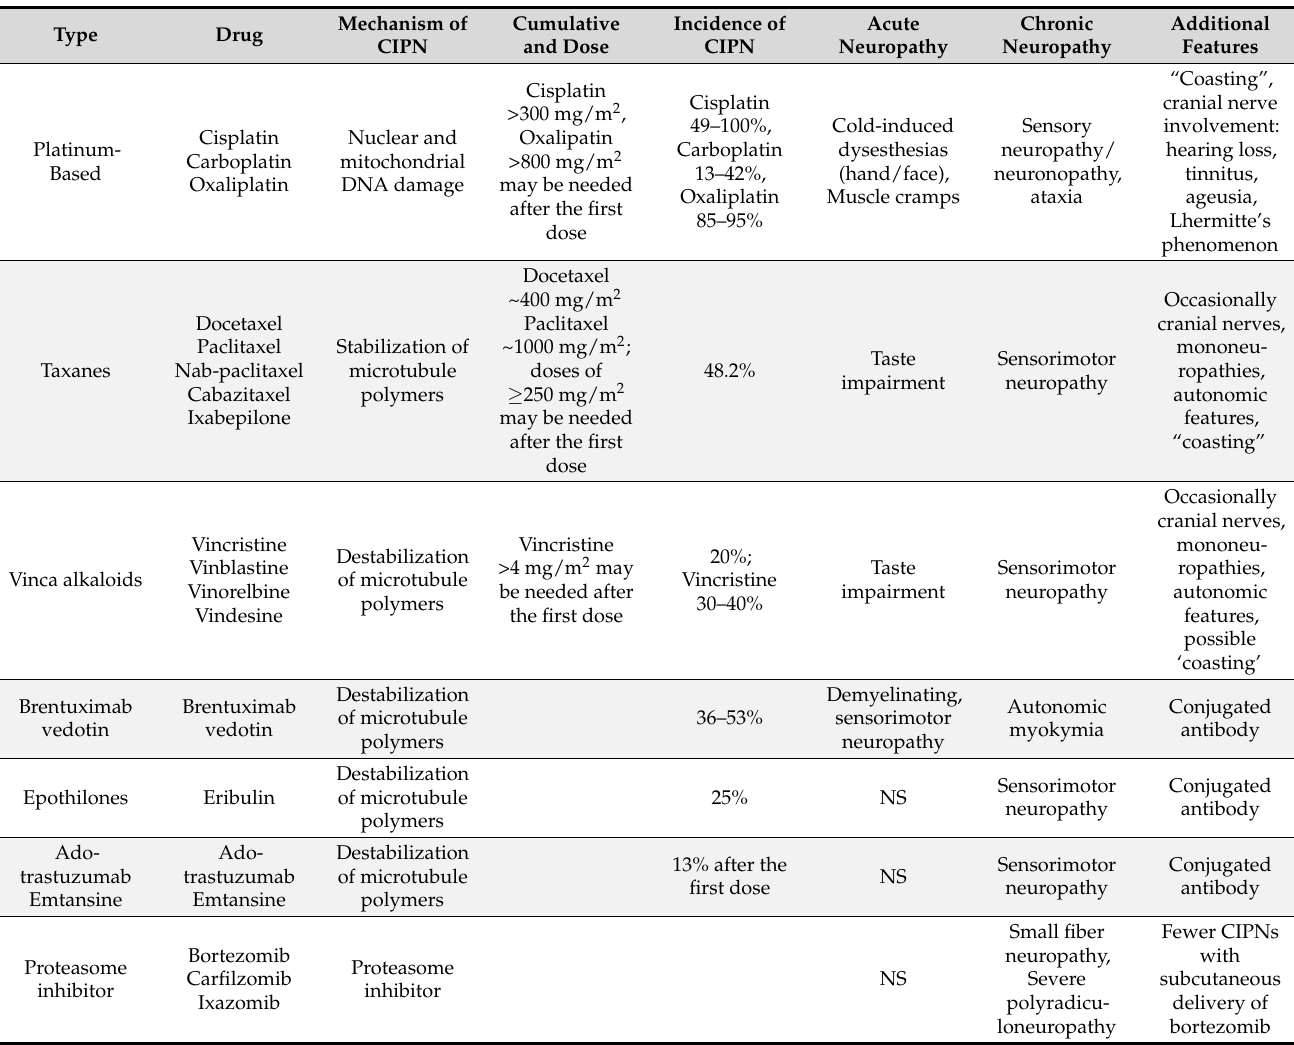
Abbreviations: NS, not